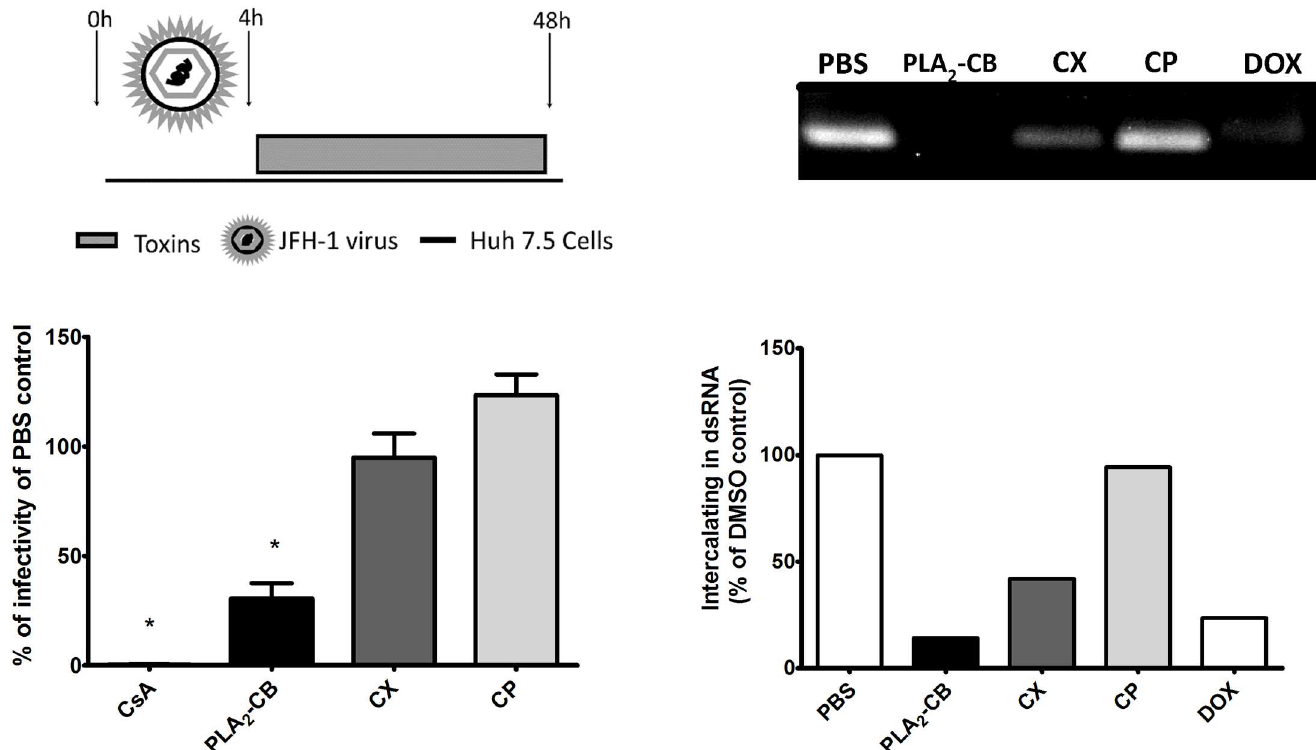
Fig 4. Effect of toxins on HCV replication. Huh7.5 cells were infected with JFH-1 HCVcc for 4 h, Then cells were washedextensively to remove virus and treated with toxins. Replicationlevels were assessed by performingthe focus formation units assay 48 h post-infection. PBS was used as negative control and CsA as positive control for replication inhibition.Mean values of three independent experiments each measuredin triplicate includingthe standarddeviationare shown. P < 0.001 was considered significant(A). In an attempt to determine de antiviral mechanismof action of these toxins, synthesized dsRNA was incubatedwith each toxin for 45 min and submitted to electrophoresis in 1% agarosegel. PBS was used as negativecontrol and Doxorubicin (DOX) was used as intercalating positive control (B).